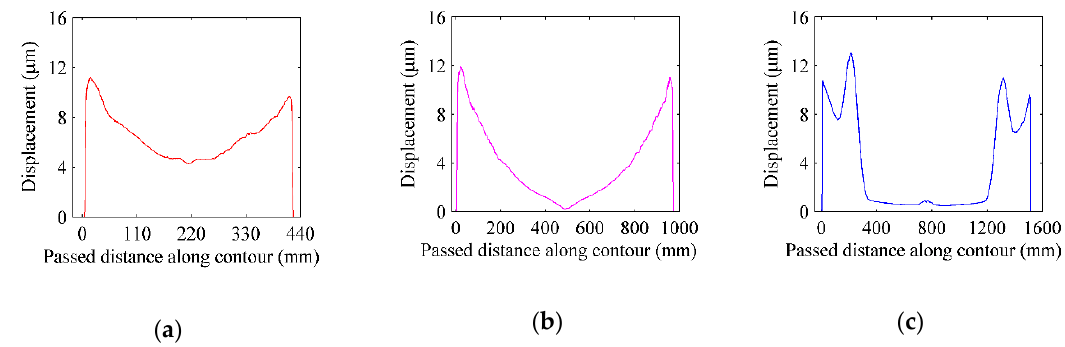
Figure 12. Predicted vibration response in the milling process along contour paths from at the height of ( a ) 120 mm (HP); ( b ) 80 mm (MP); ( c ) 40 mm (LP).